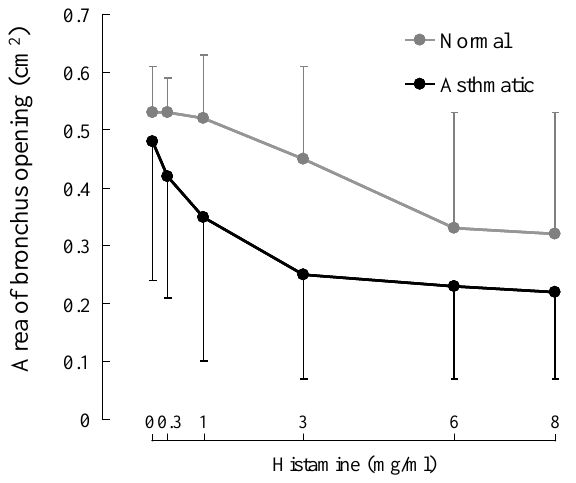
Fig. 6. Area of bronchus opening before and after histamine challenge. The bronchus opening was quantitatively assessed by the image-based method during tidal breathing while inhaling either saline solution without histamine (0 mg/ml), or with histamine at consecutively increasing concentration from 0.3mg/ml to 8 mg/ml, respectively. The results are given as mean (cid:2) SD. *, # indicates p < 0 : 05 and 0.01, respectively for comparison between normal and asthmatic groups at each dose, n ¼ 10.